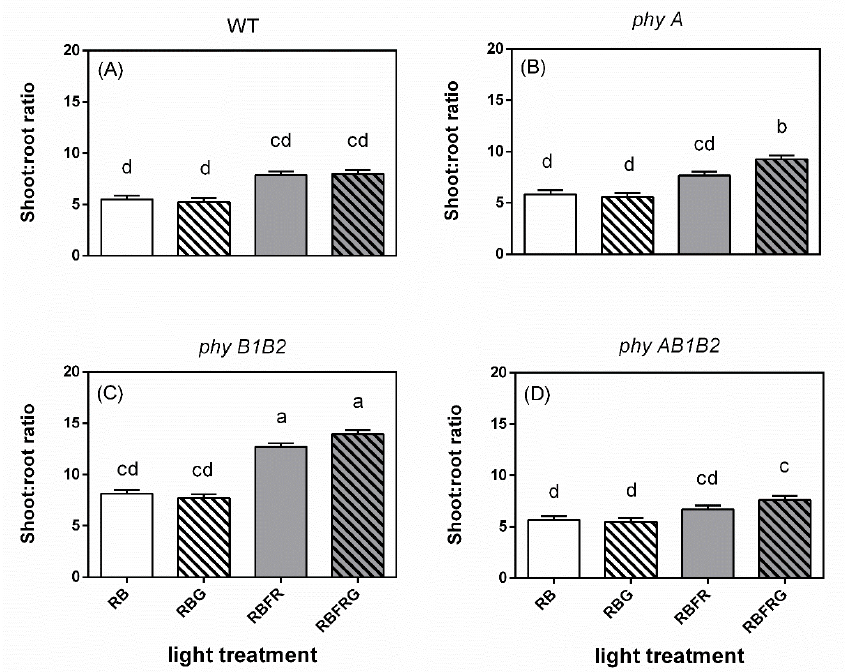
Figure 5. Effect of partial (20%) substitution of red/blue (RB; 3:1) with green (G) light in the presence or absence of far-red light (FR) on the shoot/root ratio of tomato plants 21 days after treatment. Four genotypes were studied: ( A ) WT (Moneymaker, wild-type), ( B ) phyA (phytochrome A-deficient), ( C ) phyB1B2 (phytochrome B1- and B2-deficient), and ( D ) phyAB1B2 (phytochrome A-, B1-, and B2-deficient). Light treatment and genotype significantly interacted ( p = 0.001). Lower case letters indicate significant differences among the combinations of light treatment and genotype ( p = 0.05), thus also allowing comparisons between panels ( A – D ). Data presented are averages, with the SE based on 5 blocks ( n = 5), each containing 3 replicate plants (Exp1).